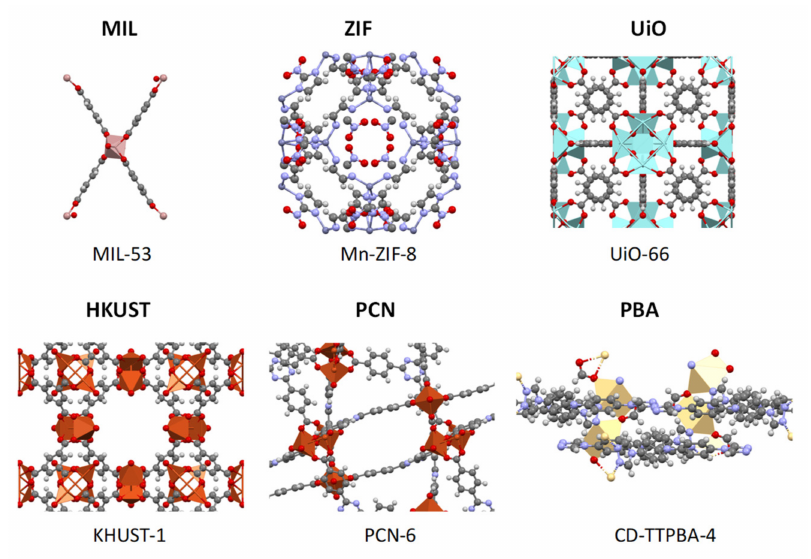
Figure 1. MOF structures (reproduced from CSD MOF Collection [19] under license CC BY-NC-SA